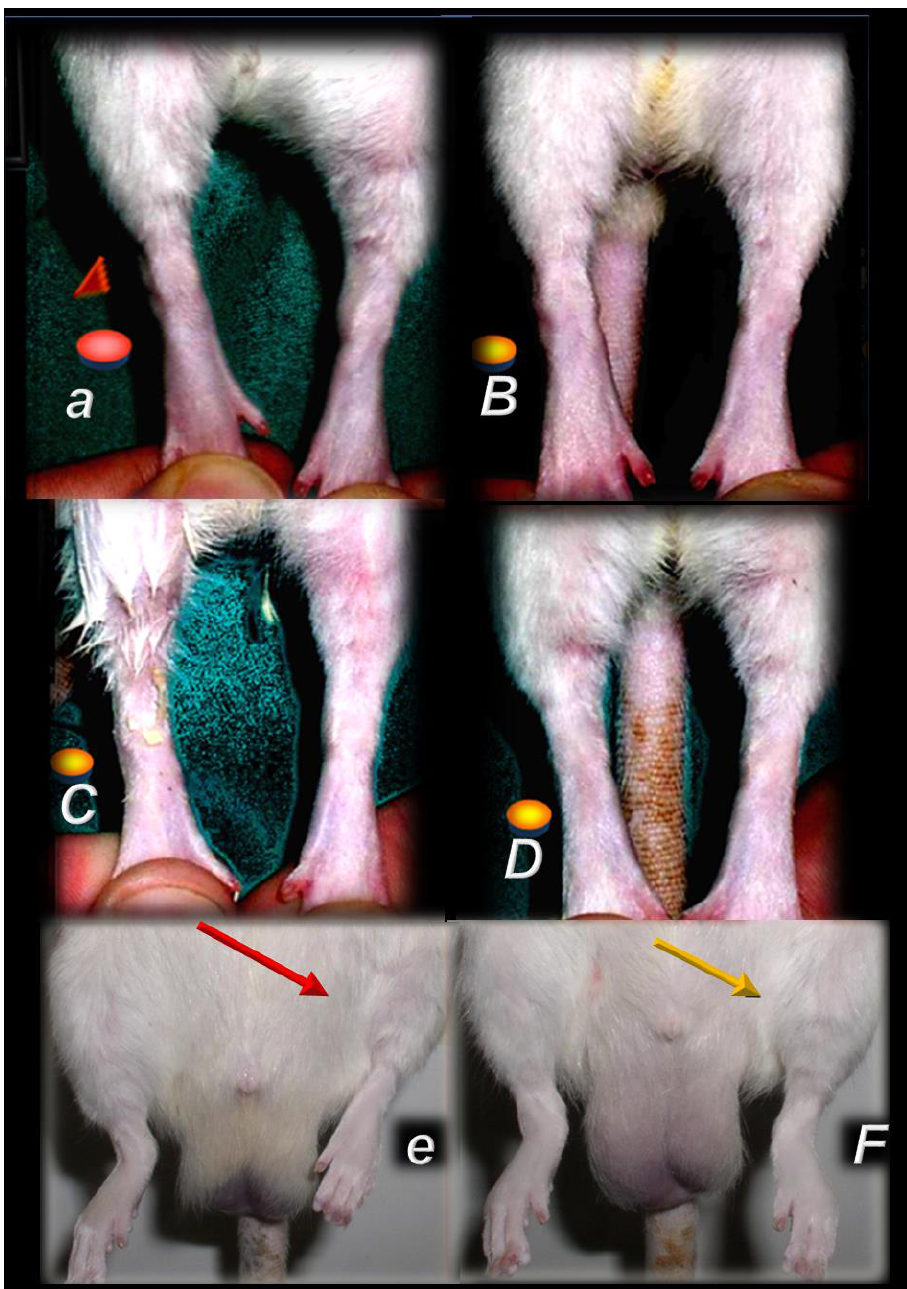
Figure 7. Injured leg contracture, prominent in the controls (small letters), following muscle transection at 72 days post-injury [44] ( a ) or denervation at one year [47] after injury ( e ), or, in contrast, fully counteracted in pentadecapeptide BPC 157 treated rats (capitals) (quadriceps muscle transection ( B – D ), gracilis muscle denervation ( F )). In the rats, which underwent major muscle transection, leg contracture in controls upon maximal extension (red circle, red triangle) ( a ). Contrarily, BPC 157 rats presented no contracture of the injured leg (yellow circle) in the BPC 157 rats. The following BPC 157 regimens were used: per-orally, 10 ng/kg, in drinking water, 0.16 ng/mL; 12 mL/rat/day ( B ), locally with cream (1 µ g/g neutral cream, thin layer once daily) ( C ), and intraperitoneally 10 µ g/kg/day ( D ). Illustrative presentation of the injured leg at one year after denervation (cut obturator nerve), presentation of injured leg (rats in up-right position) with spontaneous contracture (red arrow) in control rats ( e ). Contrarily, injured leg presented without contracture with BPC 157 (10 ng/kg/day, intraperitoneally) (yellow